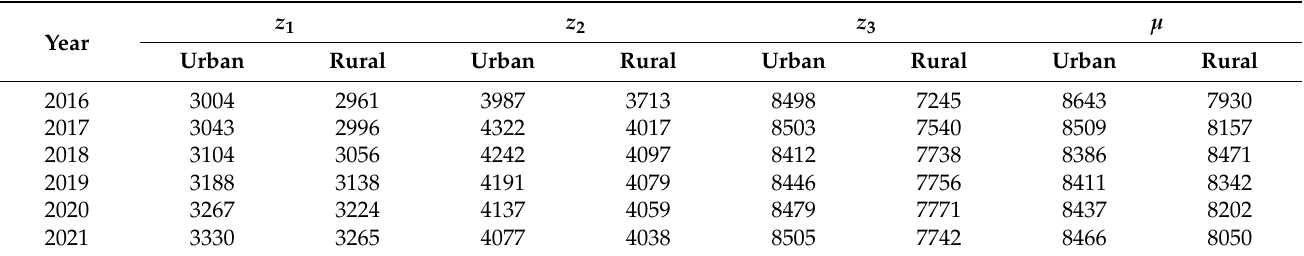
Table 2. Poverty line and per capita net income from 2016 to 2021 (unit: